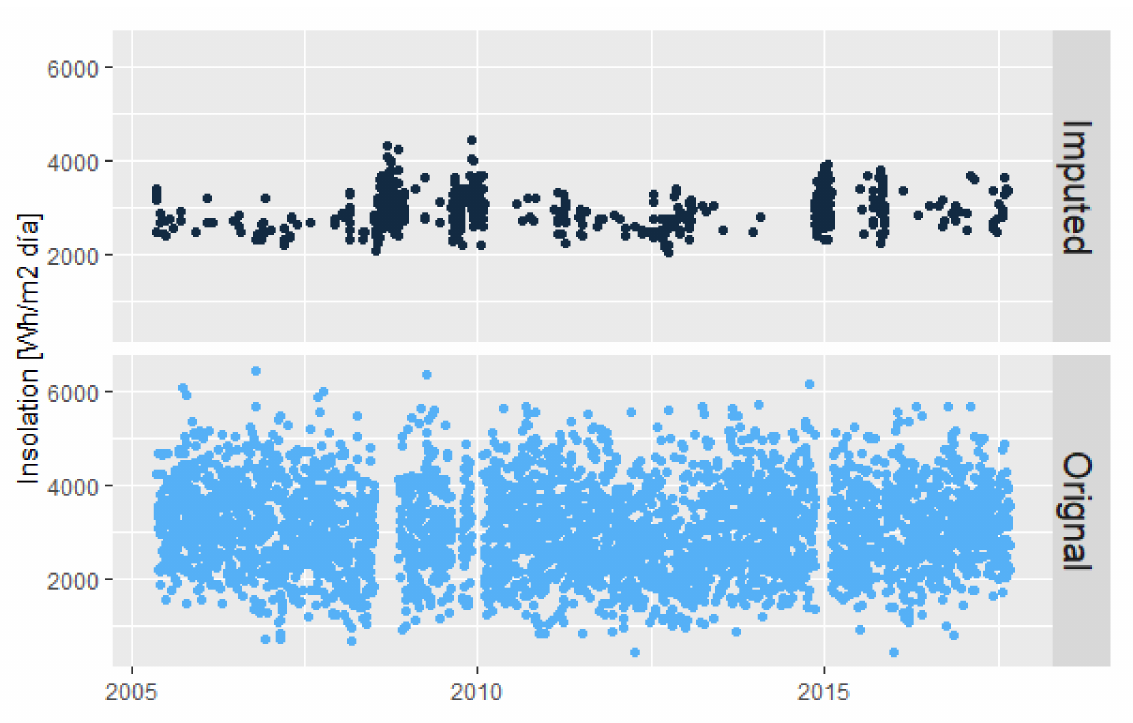
Figure 16. Botana